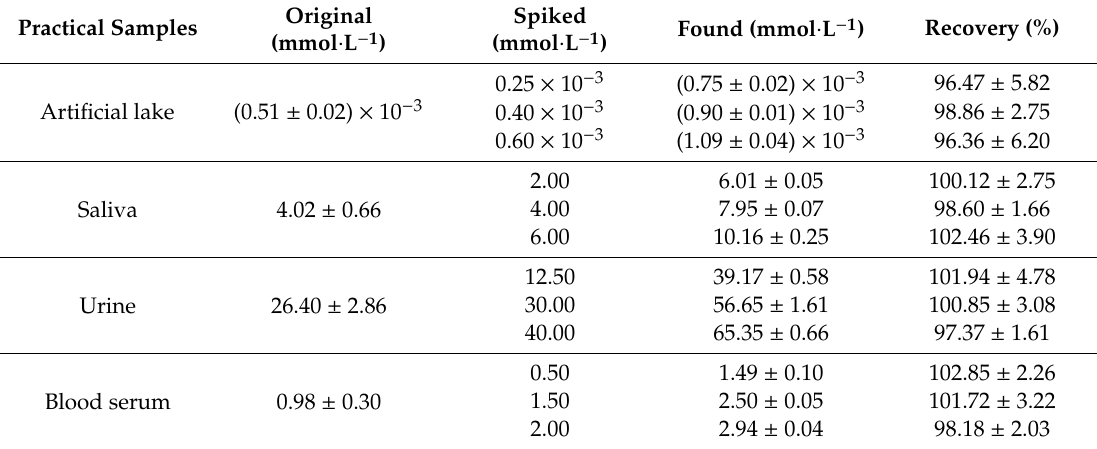
Table 2. The determination results of phosphate for four kinds of sample matrixes ( n = 3, 95% confidence